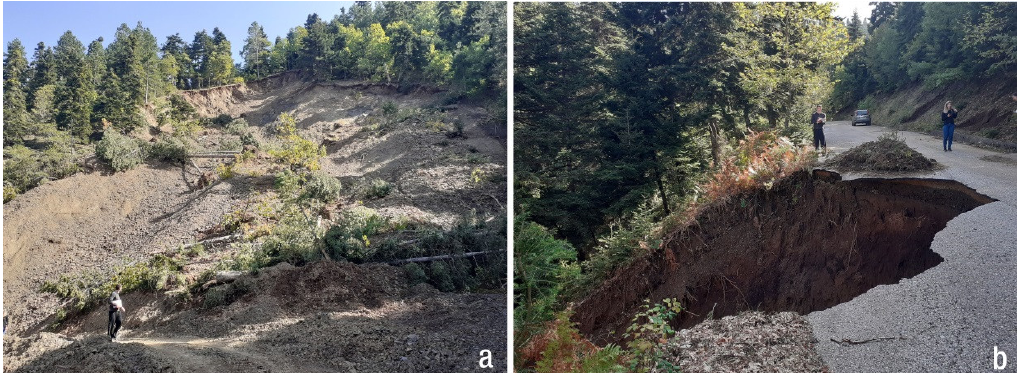
Figure 7. Characteristic rotational failures around Amarantos area. ( a ) large failure in siltstone flysch west of Itamos village and ( b ) failure in weathered flysch mantle material causing damage to the road.